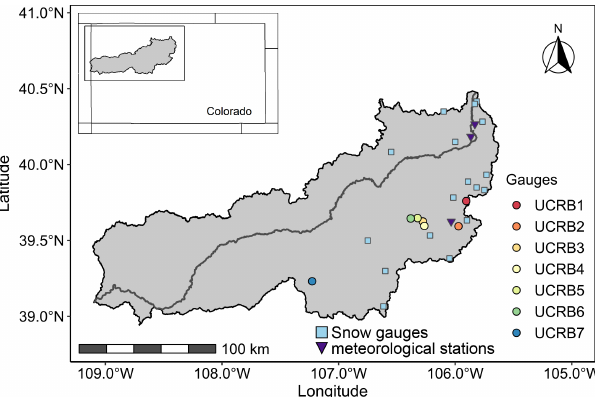
Figure 2. Streamflow gauges in the Upper Colorado River basin (UCRB) considered in this study. Light blue squares correspond to the snow gauges (18) and purple triangles to the meteorological sta- tions (3) considered in this